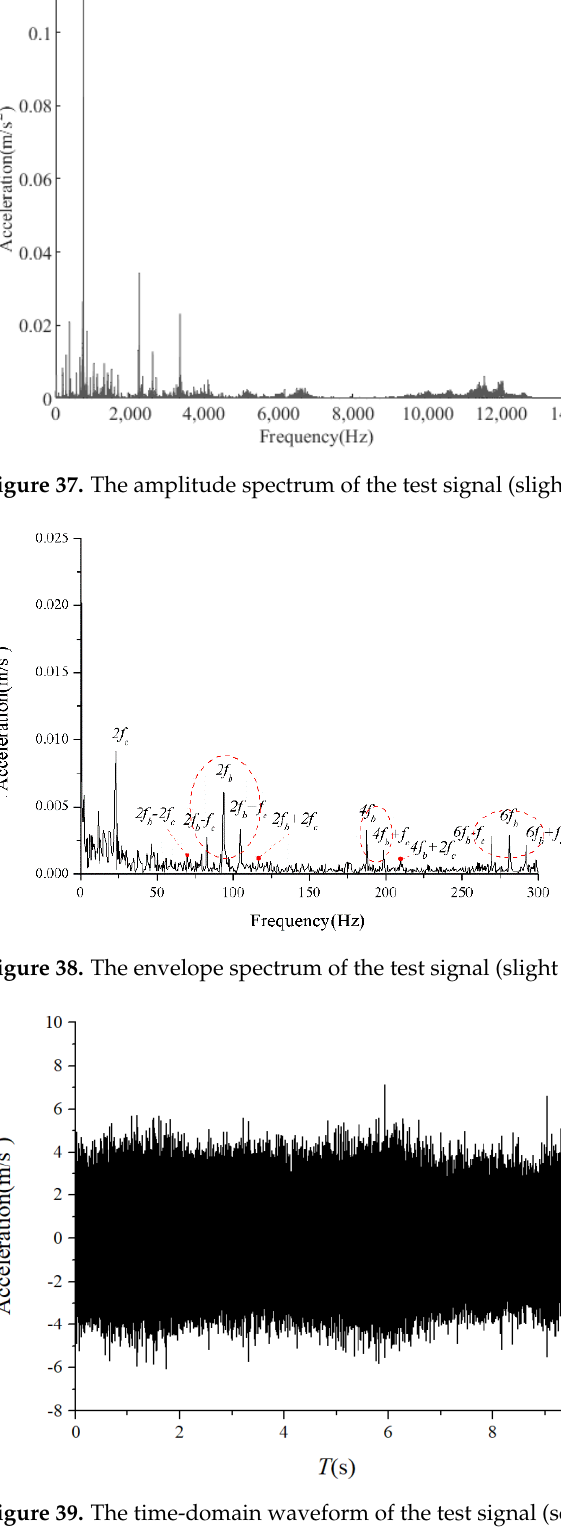
Figure 40. Acceleration spectrum (severe friction).